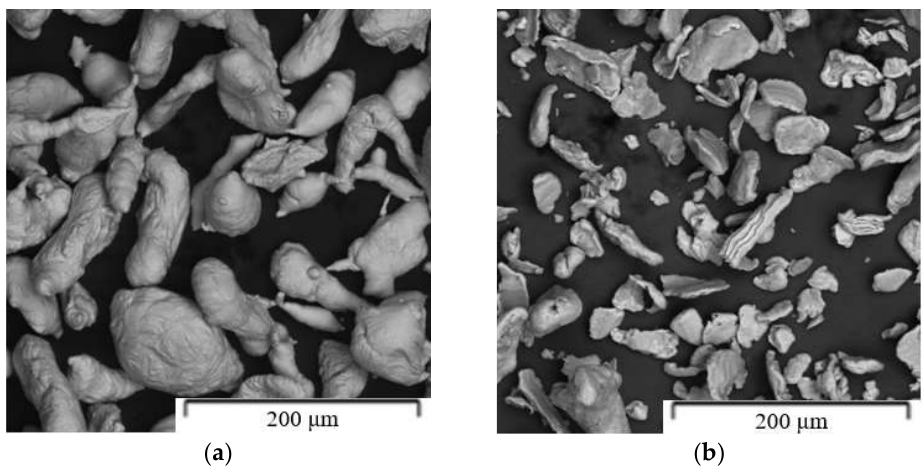
Figure 1. Shape and morphology of the initial powders: ( a ) Zn, ( b ) Mg. Table 1. Summary of mechanical alloying conditions.